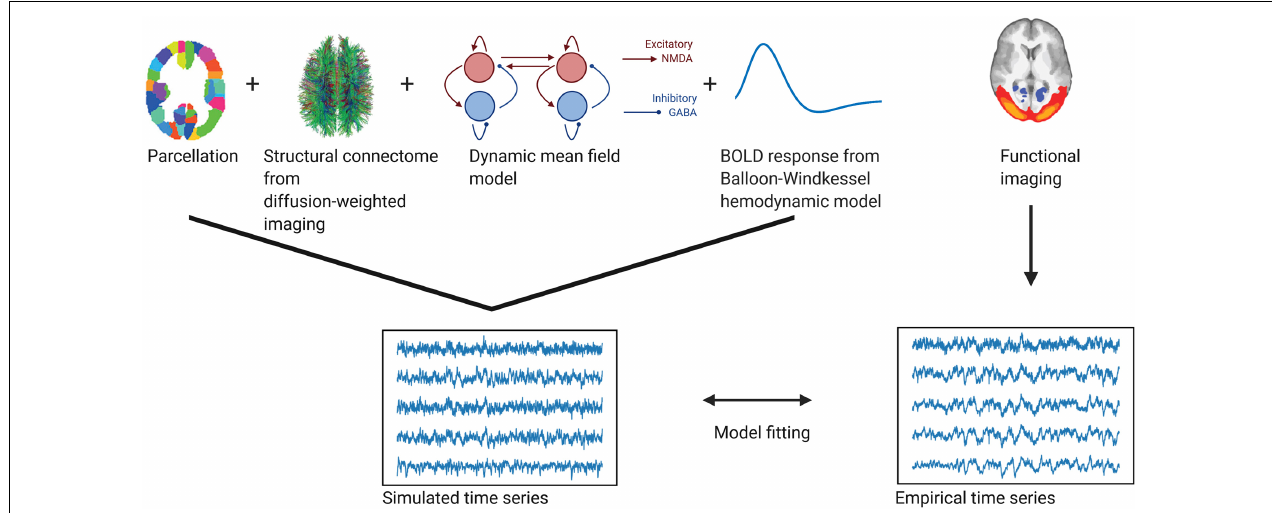
FIGURE 1 | Whole-brain modeling steps to create simulated functional time series fitted to empirical BOLD data. Using a whole-brain network model such as the dynamic mean field model allows us to accurately create time series data at different temporal scales. Local dynamics of each region given by a parcellation are generated by a dynamic mean field model and coupled through the structural connectome (as provided by the numbers of fiber tracts estimated from diffusion-weighted imaging). To fit the resulting neuronal time series to the empirical BOLD time series, we employ a Balloon-Windkessel hemodynamic model to create simulated BOLD time series. The simulated time series are fitted to the empirical time series using metrics of metastability and phase similarity matrix